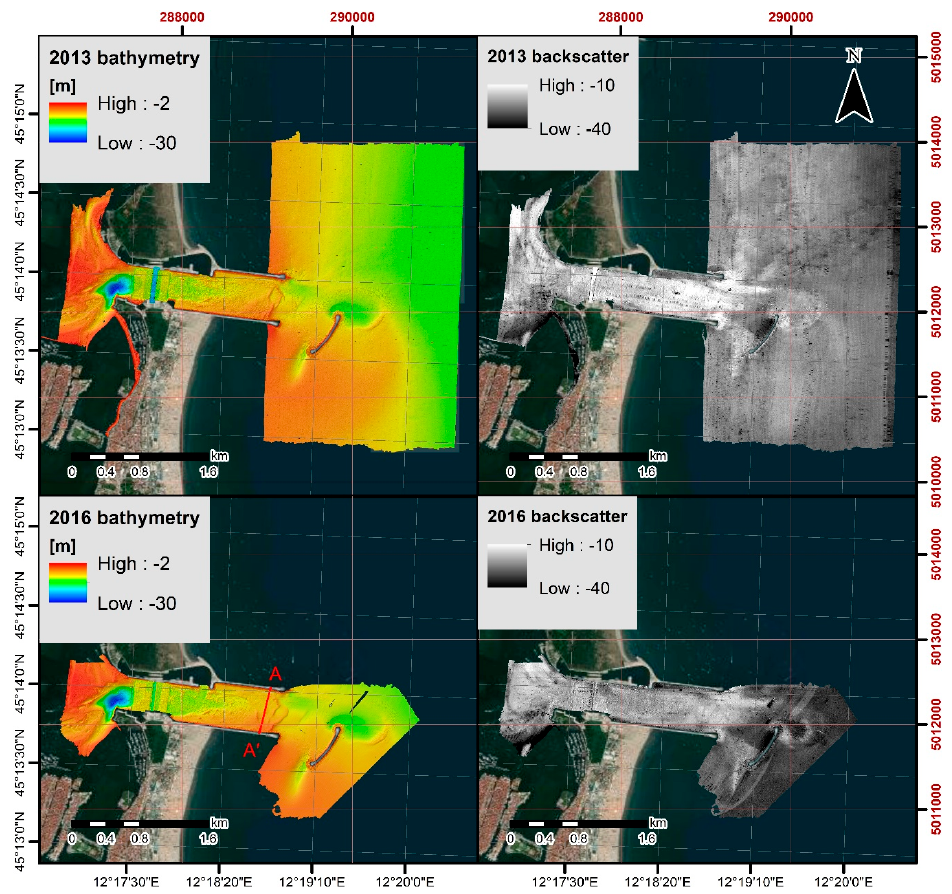
Figure 3. Chioggia inlet bathymetry ( left ) and backscatter ( right ) layers from 2013 and 2016. A bathymetric comparison between the surveys suggested a similar arrangement of geomorphological structures (e.g., dune field and large dunes at the end of the seaward tidal channel and its foreground) and progressive deepening and extension of scour holes (at breakwater